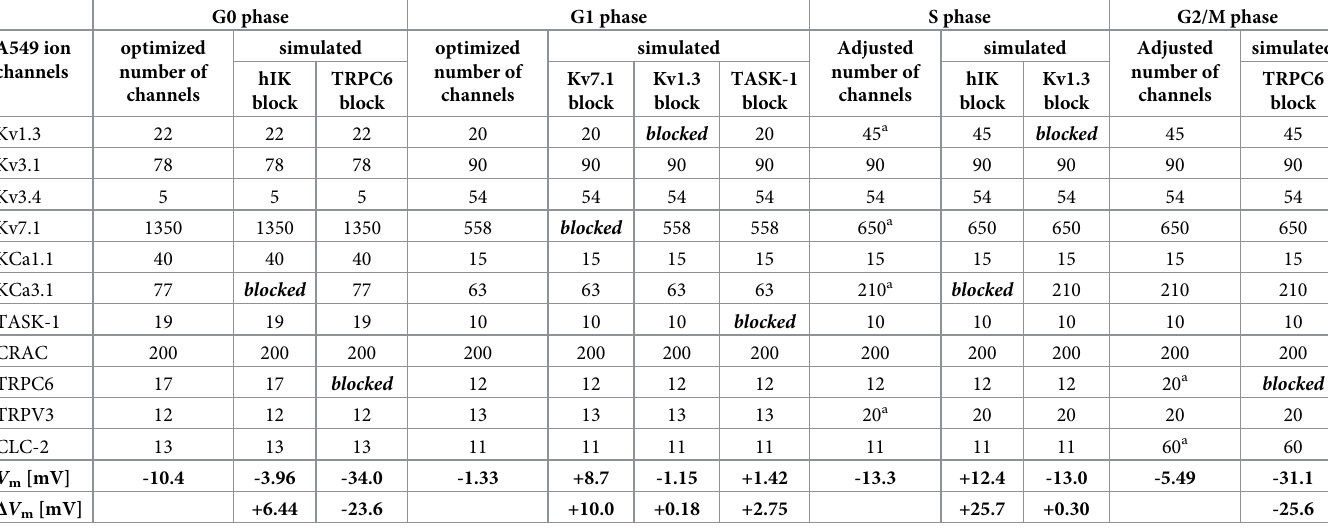
Table 2. Ion channel numbers and simulated ion channel blockages during different cell cycle phases in the A549 in-silico model. G0 phase